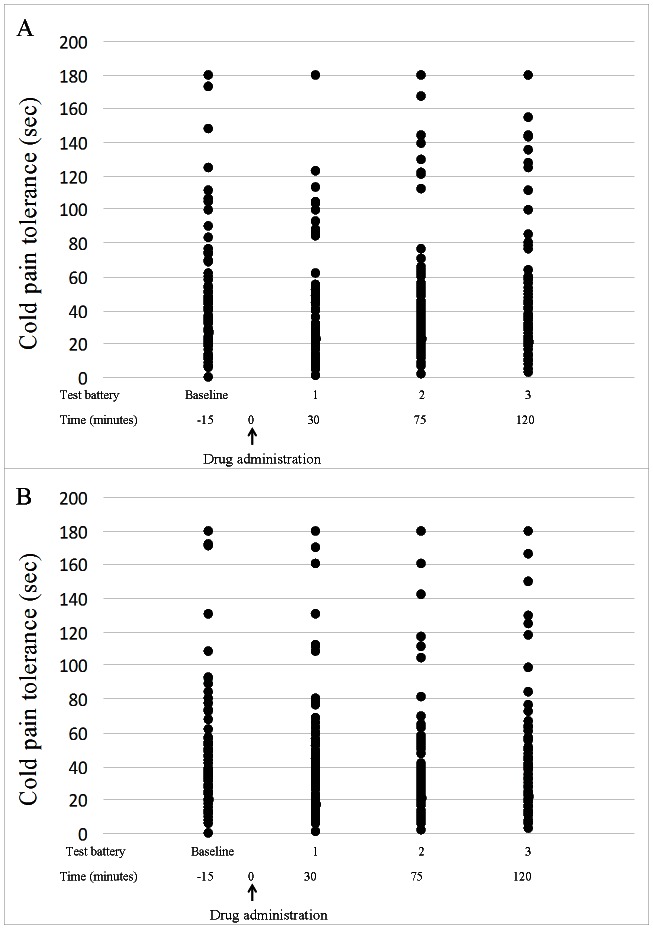
Distribution of cold pain tolerance (n = 104).Scattered plots of cold pain tolerance (sec) in the apomorphine (A) and placebo (B) conditions, measured before (baseline) and after drug administration.